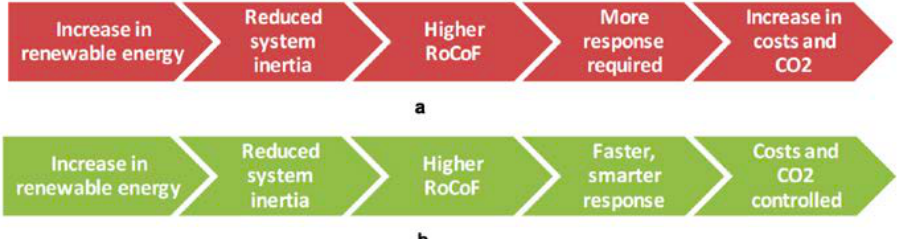
Figure 12. Control strategies for supporting frequency response: ( a ) Traditional techniques ( b ) Smart techniques.